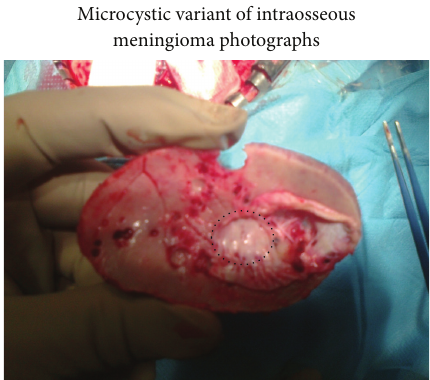
Figure 2: Operative specimen. The internal surface of the bone flap removed with the tumour. The area of the tumour located inside the osteolyticdefectofthebonewiththeadheringpartoftheduramater marked with